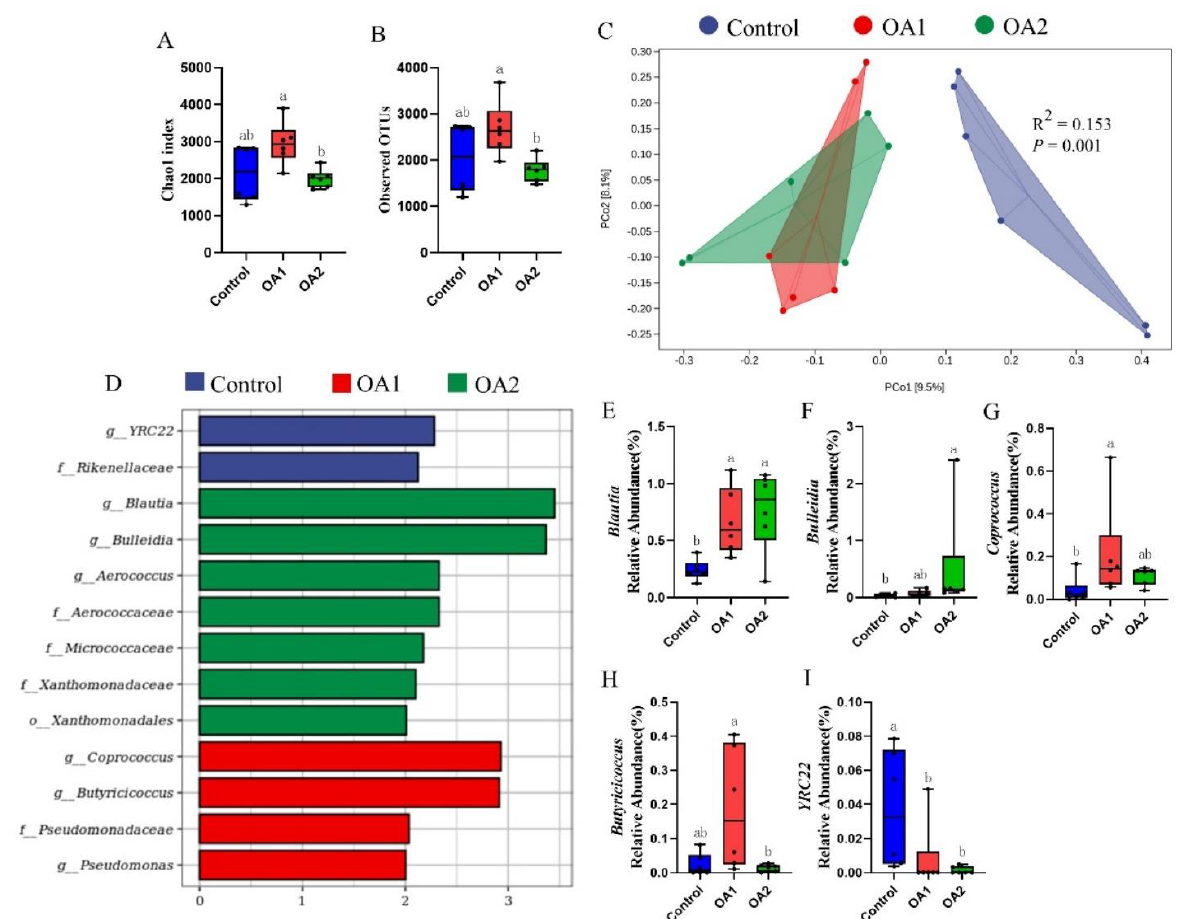
Figure 6. Gut microbiota analysis of cecum chyme at day 49. Comparison of alpha diversity index (Chao1 index and observed OTUs) among three groups ( A , B ). Principal coordinates analysis (PCoA) based on Jaccard distances ( C ). Each point in the figure represents a sample, and different colored points indicate different groups. P -values were tested by permutational multivariate analysis of variance (Adonis). LEfSe analysis effect size identified the most differentially abundant taxa in the cecal chyme microbiota community of the three groups, and only taxonomies of LDA score >2 are shown ( D ). Relative abundances of Blautia , Bulleidia , Coprococcus , Butyricicoccus , and YRC22 among the three groups ( E – I ). Labeled means with different superscript letters are significantly different ( p ≤ 0.05) by Wilcoxon’s rank-sum test ( n = 6). LDA, linear discriminant analysis.